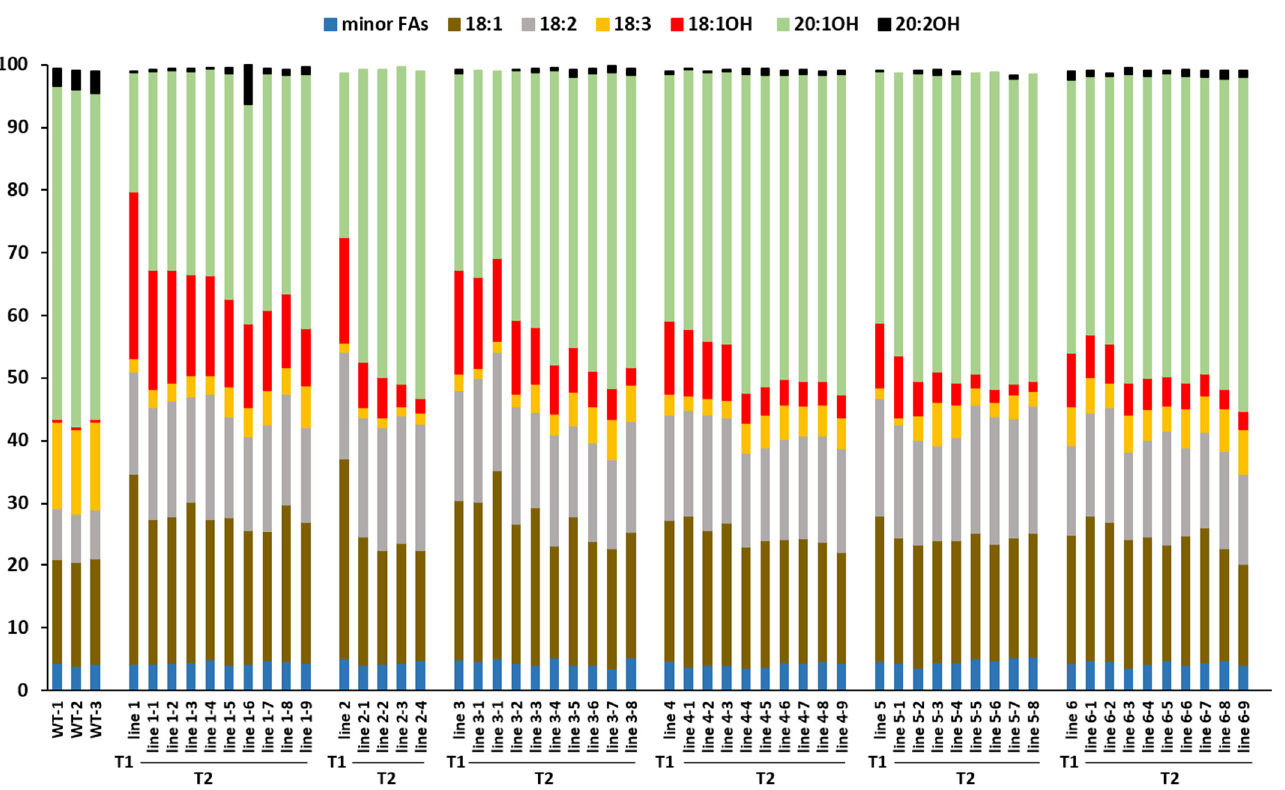
Figure 2. Fatty acid content in T2 seeds expressing AtFAD3 RNAi + CsFAE1 RNAi. Triplicates of 30-seed samples were measured for wild-type (WT) and each transgenic line. Fatty acid legend: 18:1 is oleic; 18:2 is linoleic; 18:3 is linolenic; 18:1OH is ricinoleic; 20:1OH is lesquerolic; and 20:2OH is auricolic acid. Total content of five common minor fatty acids: palmitic (16:0), palmitoleic (16:1), stearic (18:0), Arachidic acid (20:0), and eicosenoic acid (20:2OH) .